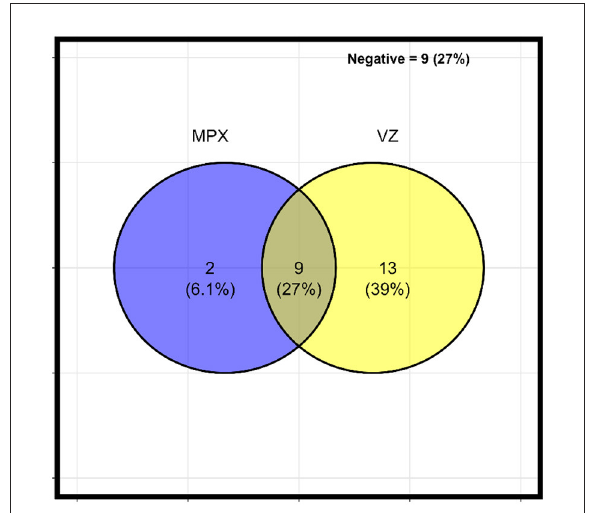
FIGURE2 Distribution of clinical diagnosis of MPX and/or VZ in Adamawa